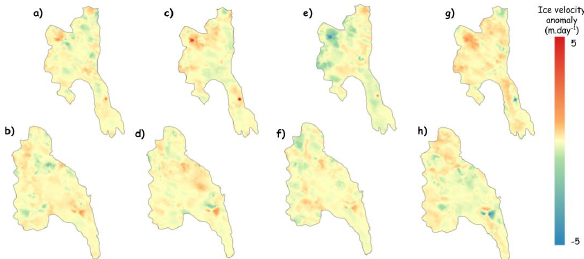
Figure 5. Grey glaciers rate of area change in the ice front from 2015 to 2019.